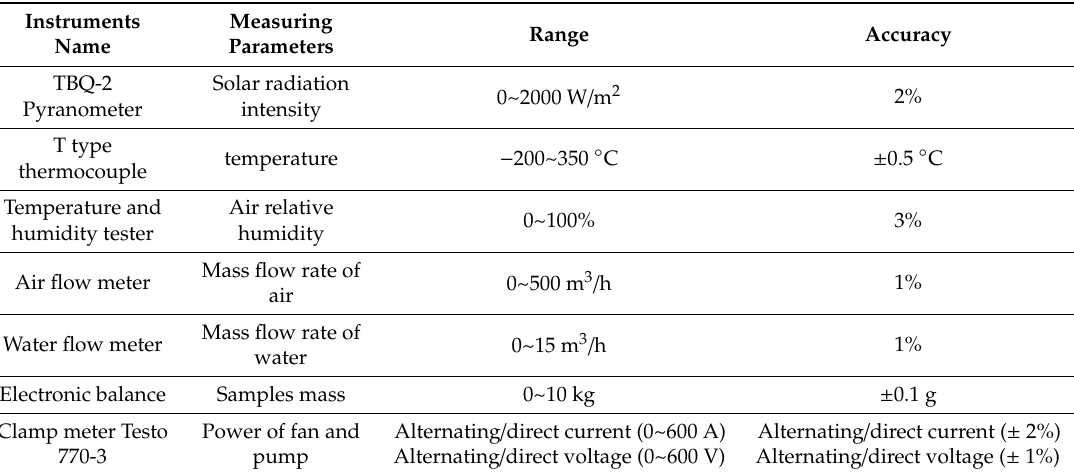
Table 2. Characteristics of the test instrument.